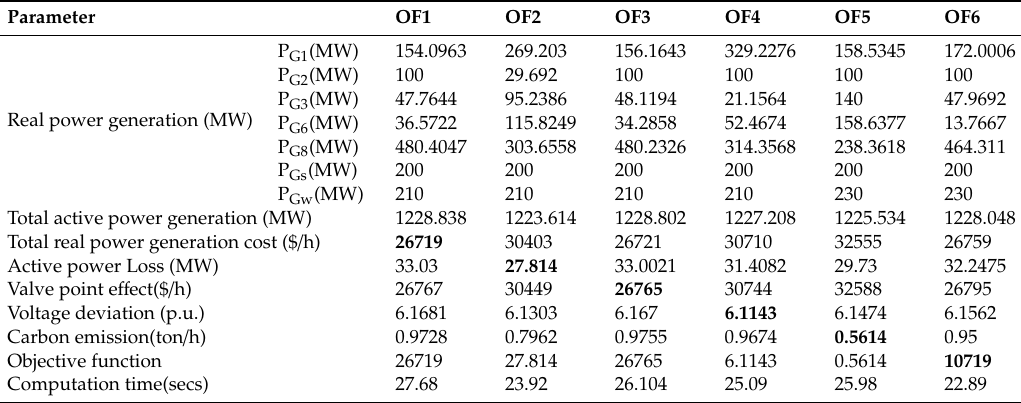
Table 10. Optimal power flowsolution with contingency and TCSC using